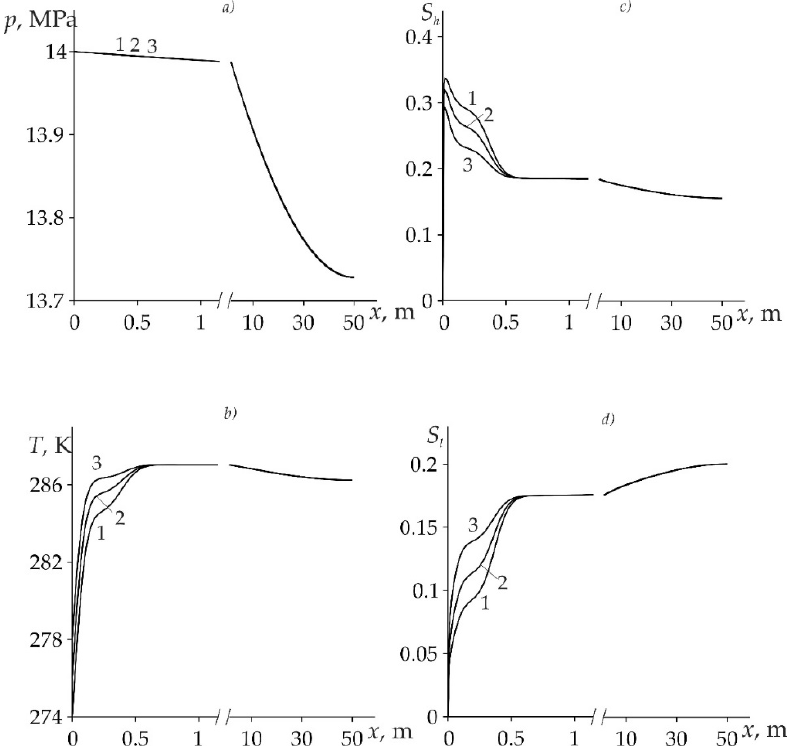
Figure 2. Distributions of pressure ( a ), temperature ( b ), hydrate saturation ( c ) and water saturation ( d ) at: T w = 274 K (1), 276 K (2), 278 K (3).